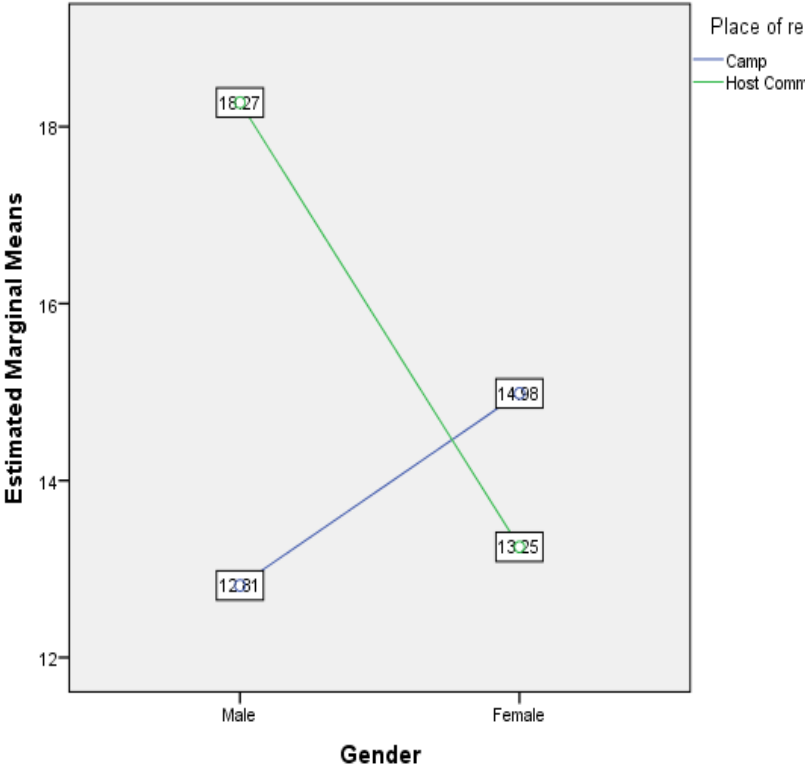
Figure 1. Interaction effect of gender and place of settlement/residence on insomnia.